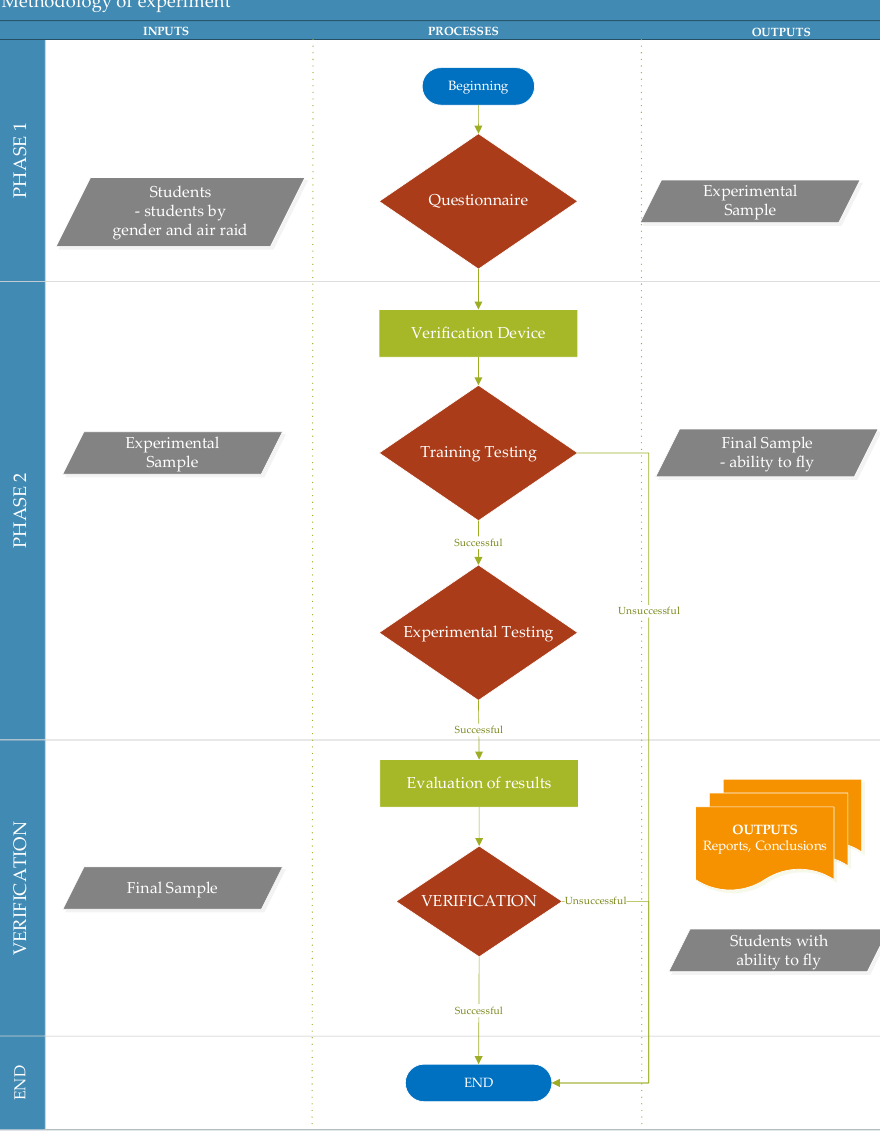
Figure 1. Algorithm of the testing